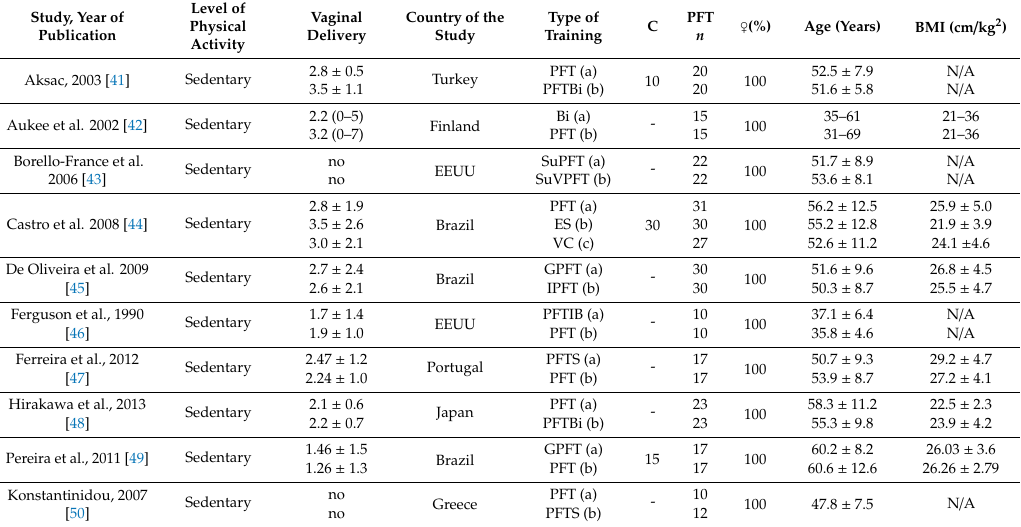
Table 1. Characteristics of the included studies in the